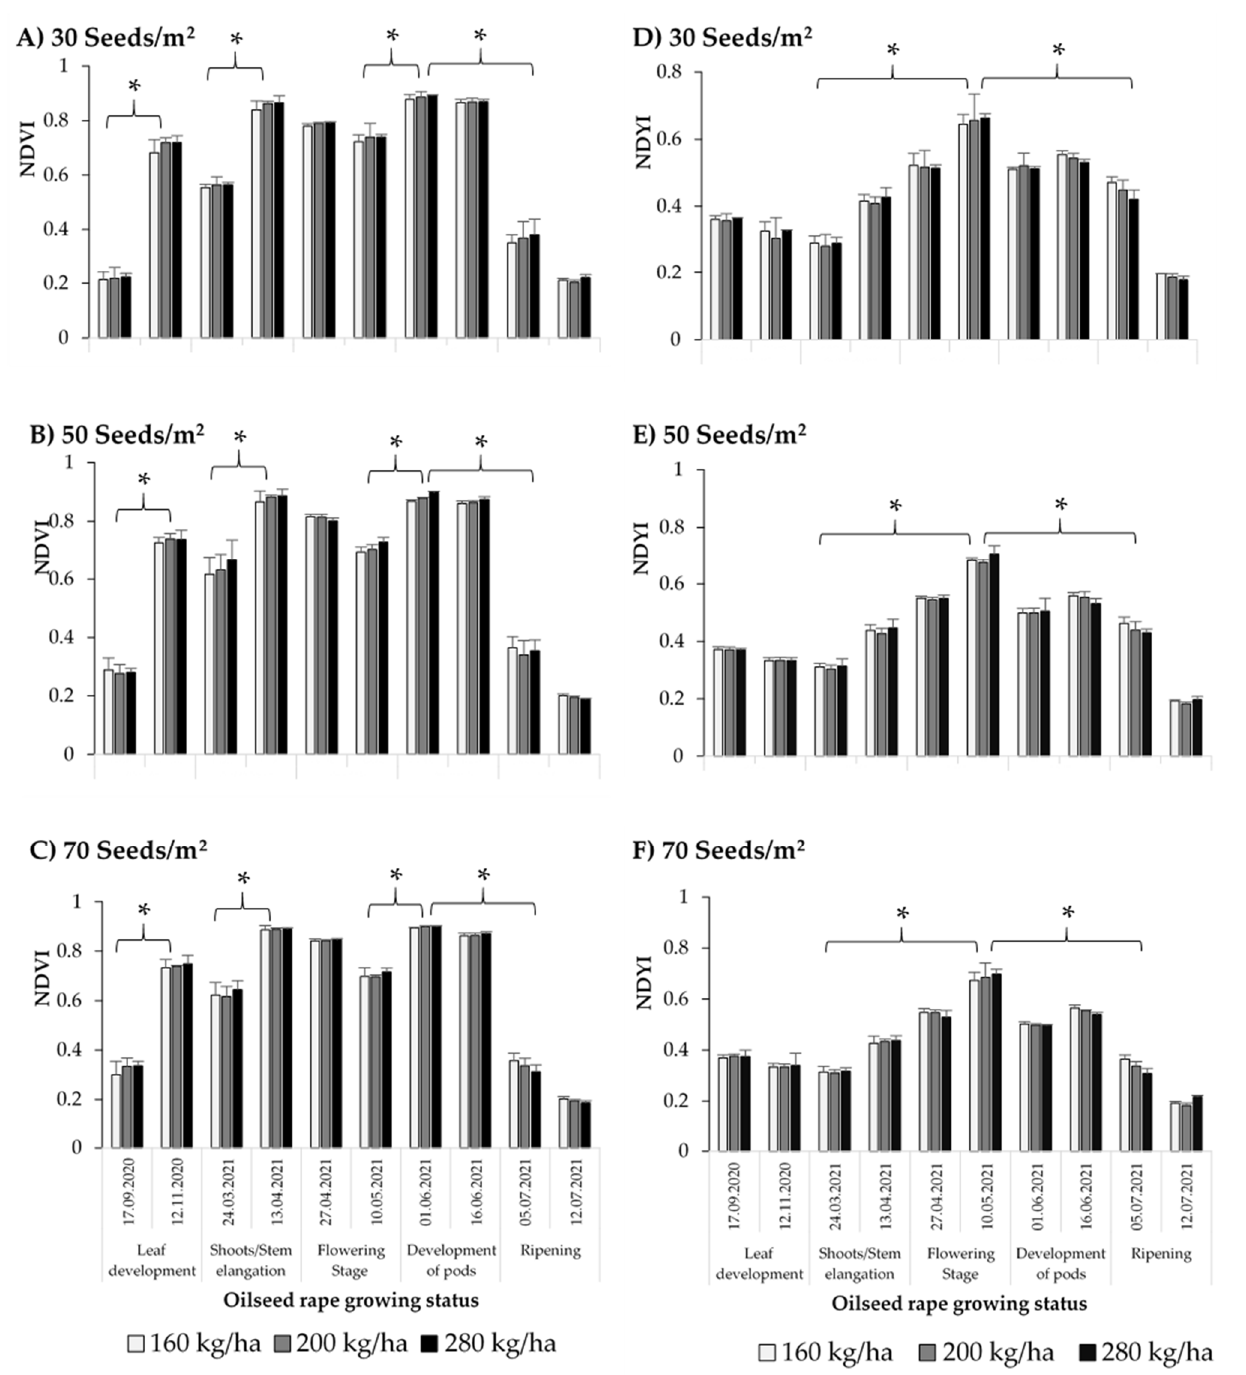
Figure 4. Monitoring winter oilseed rape growth status, from seeding to ripening stages, by normal- ized difference vegetation index (NDVI; A – C ) and normalized difference yellowness index (NDYI; D – F ) derived from UAV-based RGB imaging. A field trial (sown on 30 August 2020) with different seed densities (30, 50, and 70 seeds per m 2 ) and three nitrogen rates (160, 200, and 280 kg [N] ha − 1 ) was conducted in Salzdahlum, Germany, in 2020–2021. In this growing season, 10 flight campaigns were operated at approximately 25 m altitude. The NDVI and NDYI values for each plot (n = 4 replicates per treatment) were calculated from the reflectance at RGB and NIR bands’ wavelengths pictured in a reconstructed and segmented ortho-mosaic. Error bars indicate the standard deviation between replicates. *: Differences between growth stages are significant ( p ≤ 0.05).